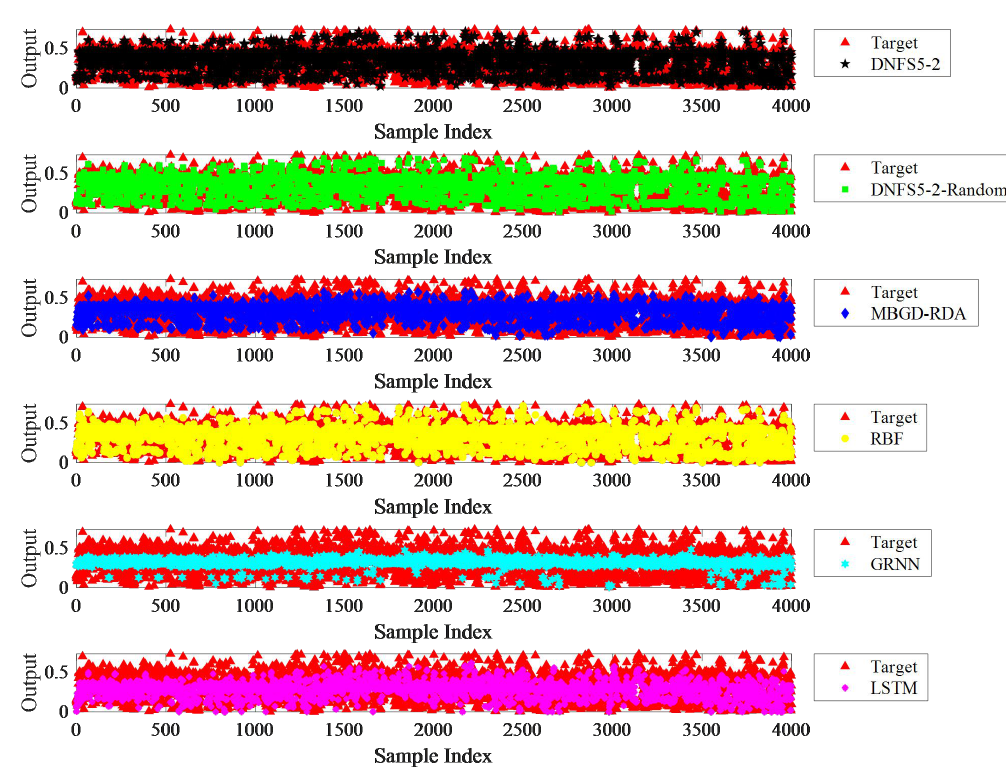
Figure 8. Prediction charts of different algorithms on Test Dataset No.